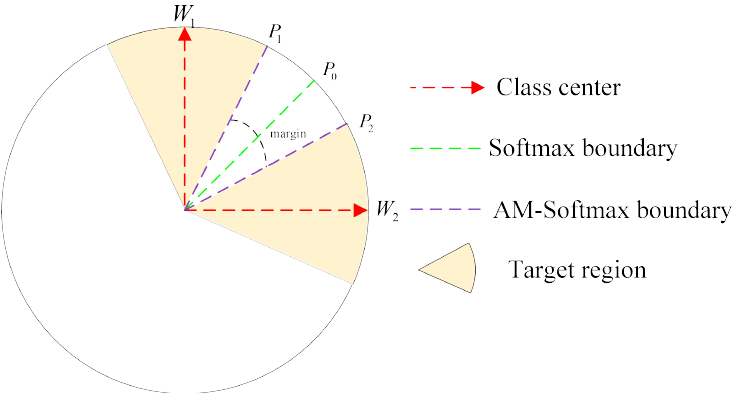
Figure 5. Conventional Softmax’s decision boundary and Addictive Margin (AM)-softmax decision